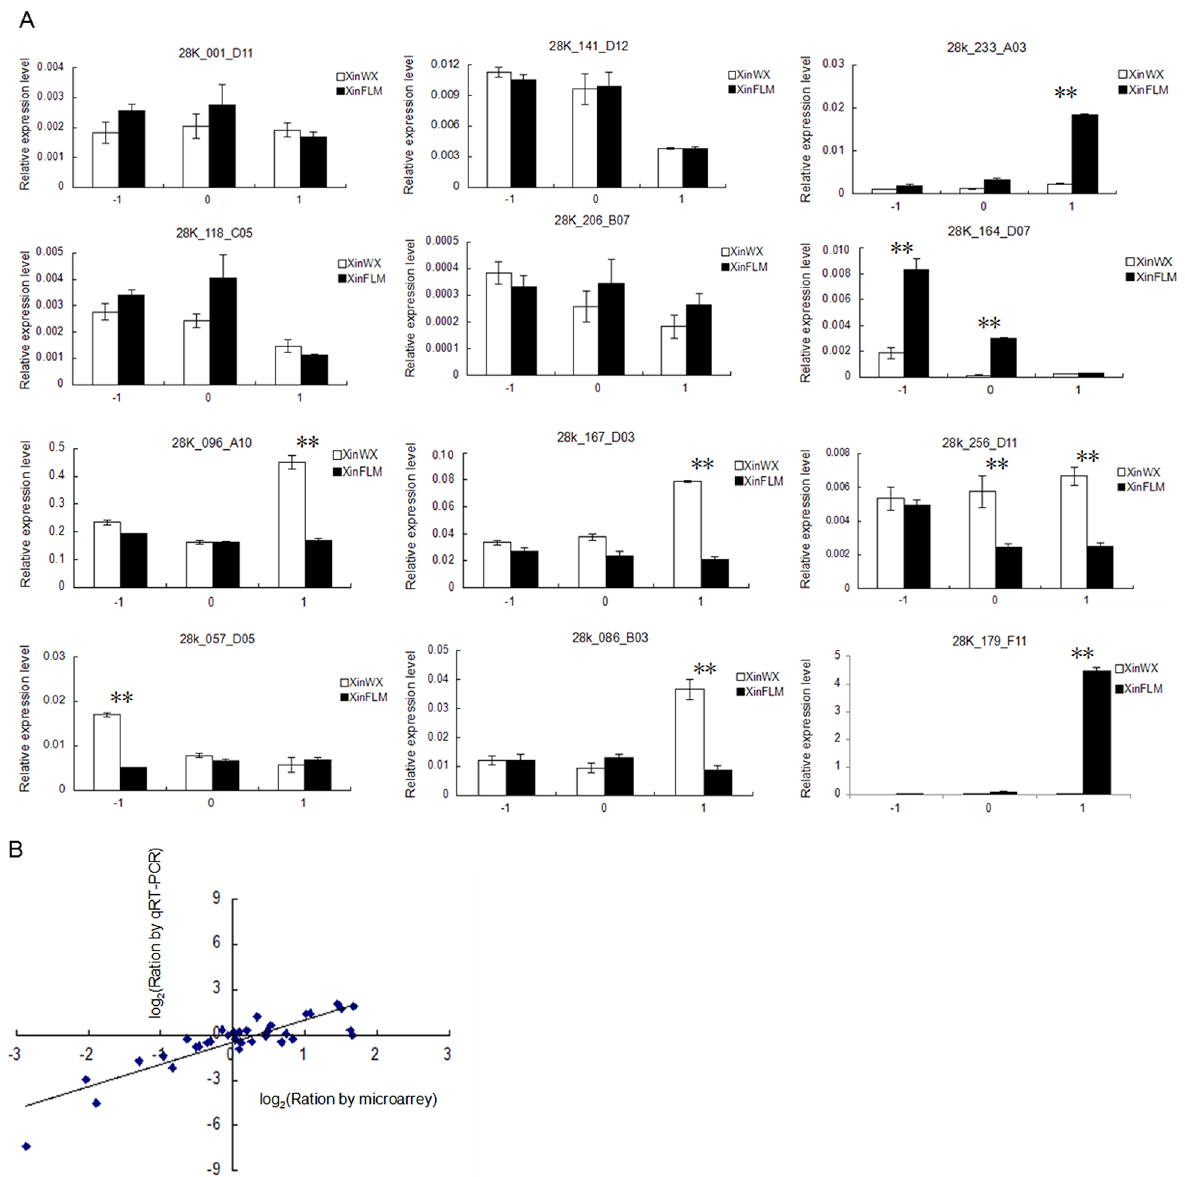
Fig 3. Comparison of gene expression ratios detected by microarray and RT-qPCR analyses. (A) Relative expression of 12 genes during fiber initiation. Mixtures of ovules and fibers at -1, 0, 1 DPA are shown. Error bars indicate ± SD of triplicate experiments. Three biological replicates were used for calculation. Significant differences at the 0.05 and 0.01 probability levels are represented by * and ** , respectively. (B) Comparison of gene expression ratios from microarray and RT-qPCR analyses. Data from 12 genes at -1, 0, and 1 DPA from XinWX and XinFLM are shown. Log 2 of the microarray expression ratios (x-axis) are plotted against log 2 of the RT-qPCR expression ratios